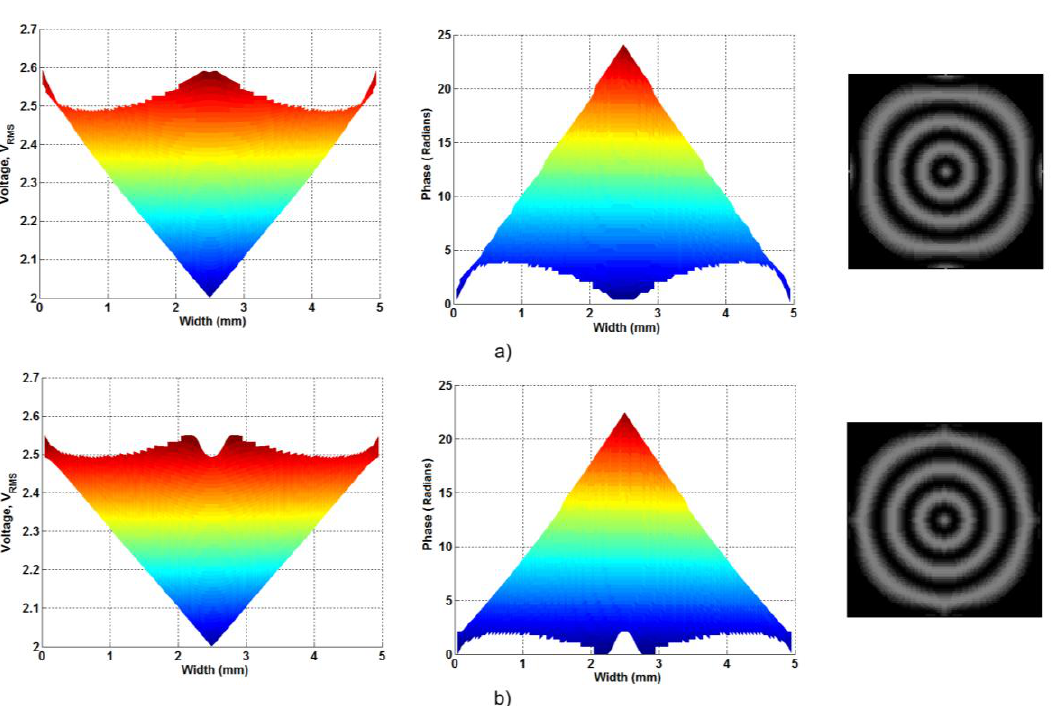
Figure 2. Voltage and optical phase shift distribution in the XZ plane, and interference pattern for ( a ) a structure without spaces and ( b ) the proposed